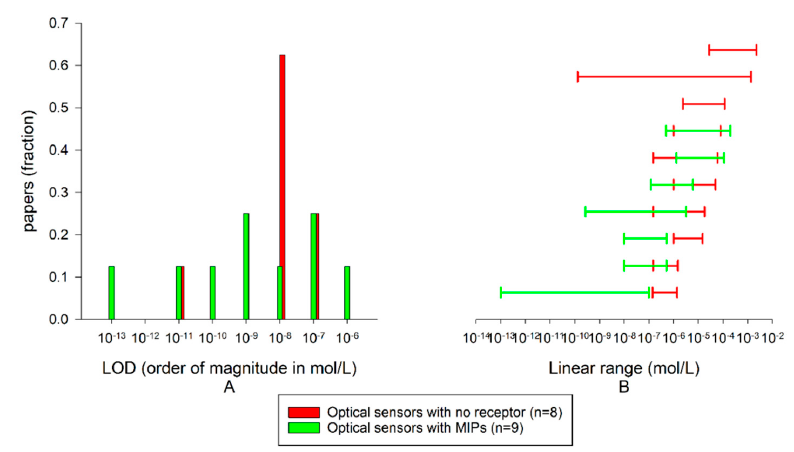
Figure 21. ( A ): distribution of LODs of optical sensors in the papers examined in this review; ( B ): linear response ranges of optical sensors in the papers examined in this review. This time the comparison is quite favorable to MIPs, as both to the number of examples with low detectabilities and to the dynamic range width. A minority of optical systems show activation of